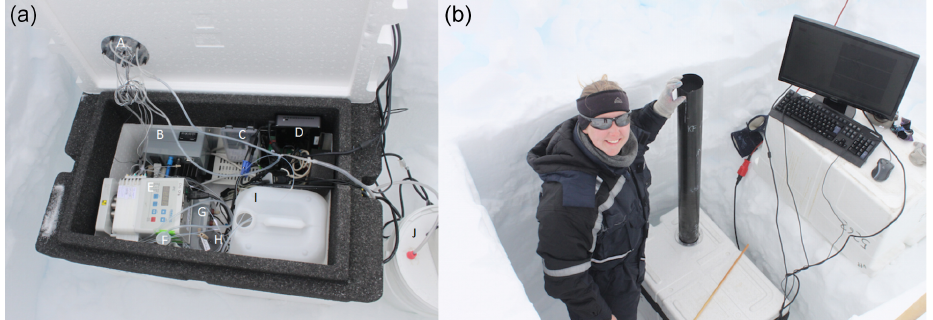
Figure 2. (a) An inside look at the LISA box. The letters in panel (a) denote the following: A – the underside of the melt head; B – the melt head temperature regulator; C – the temperature proportional integral derivative (PID) that stabilizes the inner temperature of the box; D – the computer; E – the peristaltic pump; F – the debubbler; G – the fluorescence box (F-box); H – the conductivity meter; I – the chemical wastewater container; and J – a container for collecting waste water from the outer section of the melt head, which is located outside the LISA box. (b) LISA box during field work 2017. The snow is collected in the black liner and melted continuously, while data can be observed online on the attached